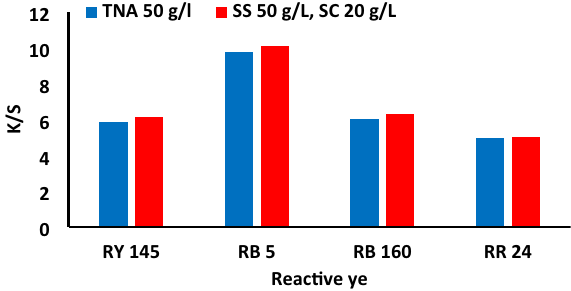
Figure 11. The color strength of different dyes on cotton fabric using 2%owf dye, LR 1:40 and TNA 50 g/L for exhaustion time 60 min and compared with its corresponding conventional dyeing method.